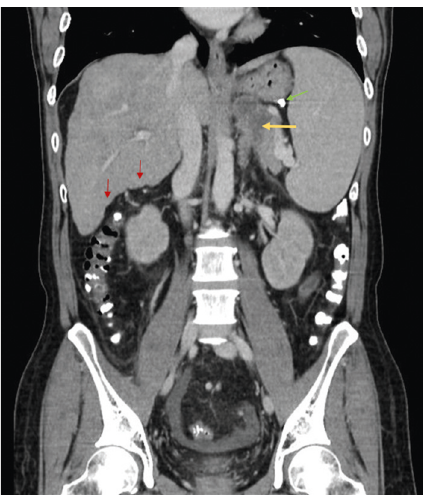
Figure 3: Computed tomography view of the abdomen (in coronal view). The liver contour is nodular (red arrows) confirming the presence of cirrhosis. There is a hypodense collection (yellow ar- row) near the splenic hilum and below the stomach, corresponding to the retrogastric abscess. The small amount of residual N-butyl-2- cyanoacrylate is brightly visible in the perigastric region (green arrow).